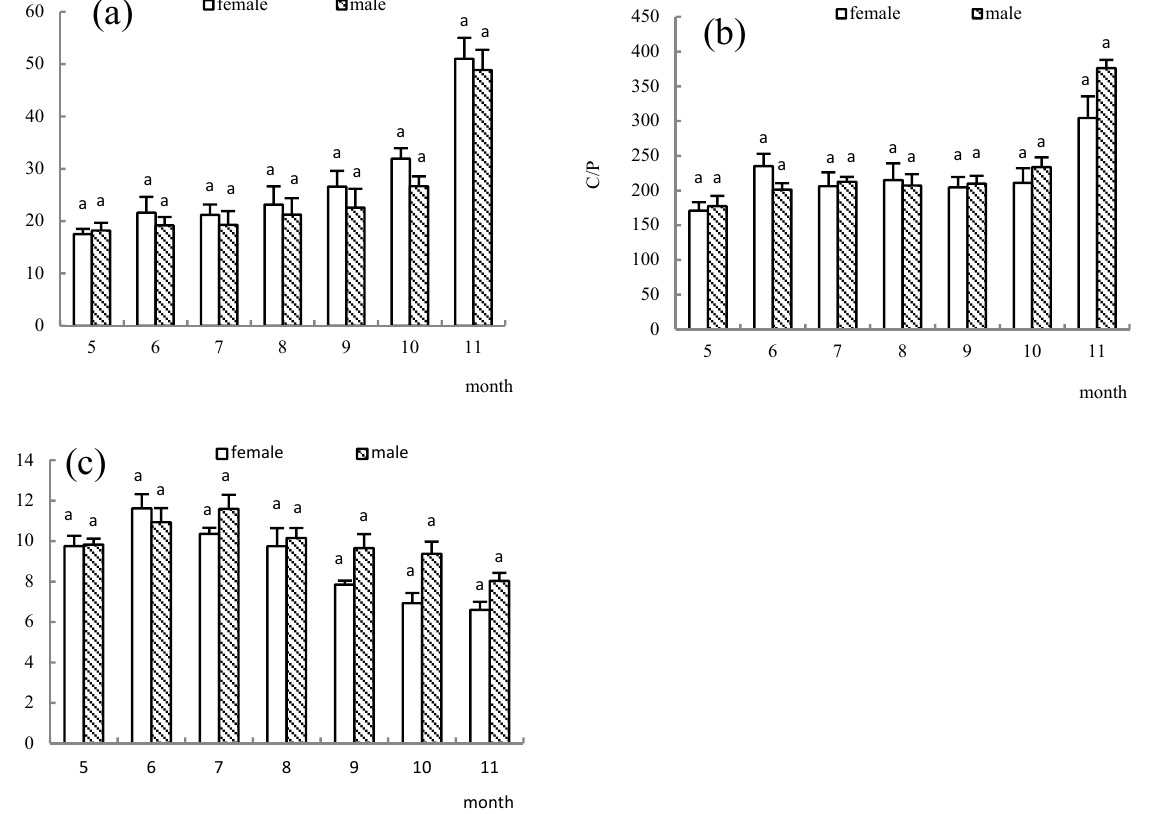
Figure 8. Comparation of C/N ( a ), C/P ( b ), N/P ( c ) ratios in branch of female and male plants of F. velutina during the growing season. Note: Means not sharing the same letter of female and male plants in the same month indicated significant differences between males and females at an alpha level of 0.05, according to one-way ANOVA.